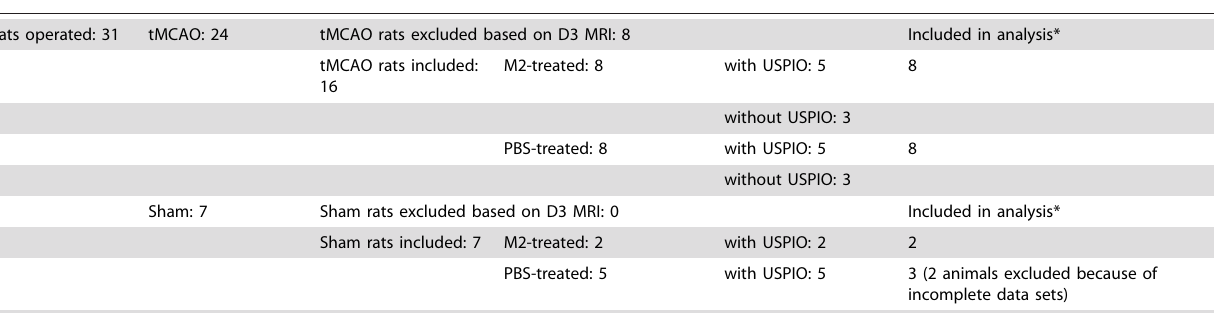
Table 1. Number of animals